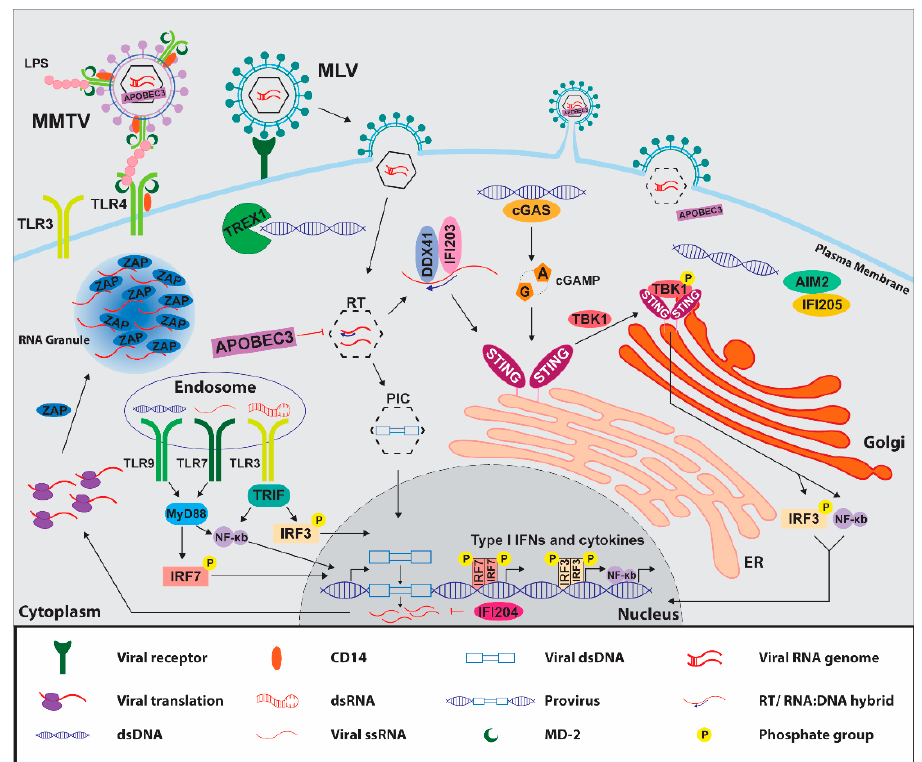
Figure 2. Retroviral replication and innate immune sensing. Murine retroviruses bind cell surface entry receptors, fuse with the cell membrane, either at the plasma membrane (MLV) or in endosomes (MMTV), and release their viral capsids into the cell cytoplasm, where reverse transcription takes place. Cytosolic sensors such as DDX41, IFI203, and cGAS detect viral reverse transcripts and upregulate transcription of type I IFNs and cytokines through STING-dependent signaling, which results in the phosphorylation of TBK1 and the transcription factors IRF3 and IRF7, or in NF- κ B activation. TREX1 degrades reverse transcripts and endogenous retroelement DNA and hinders